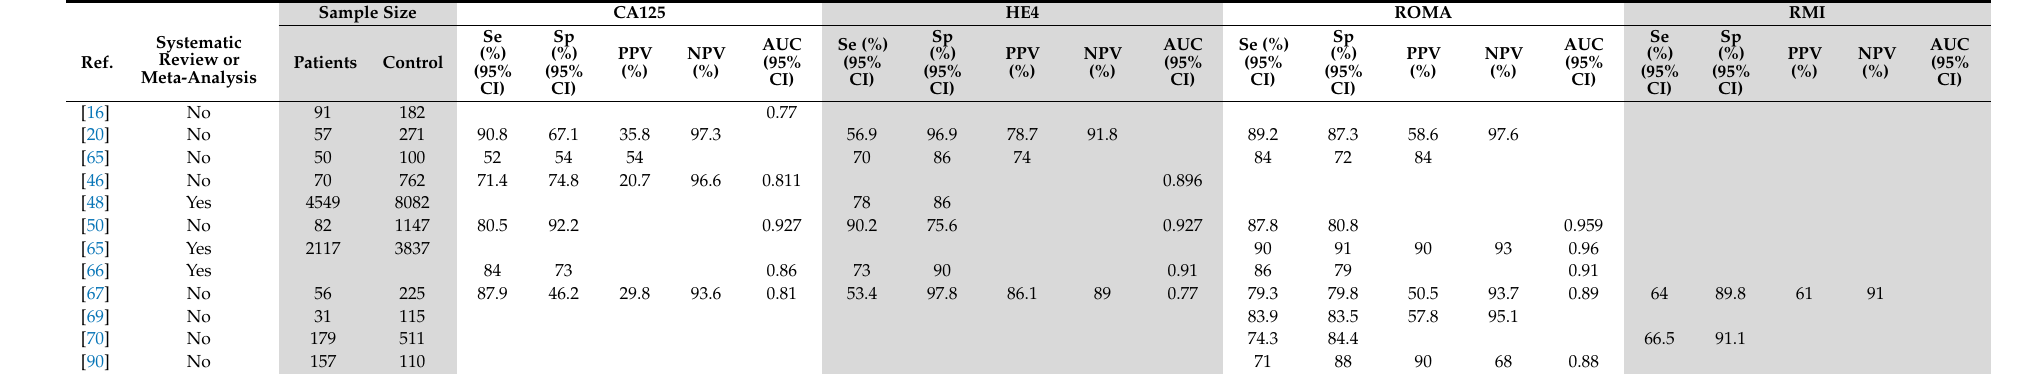
Table 1. Diagnostic performance of clinically used molecular biomarkers in the subset of studies cited in this